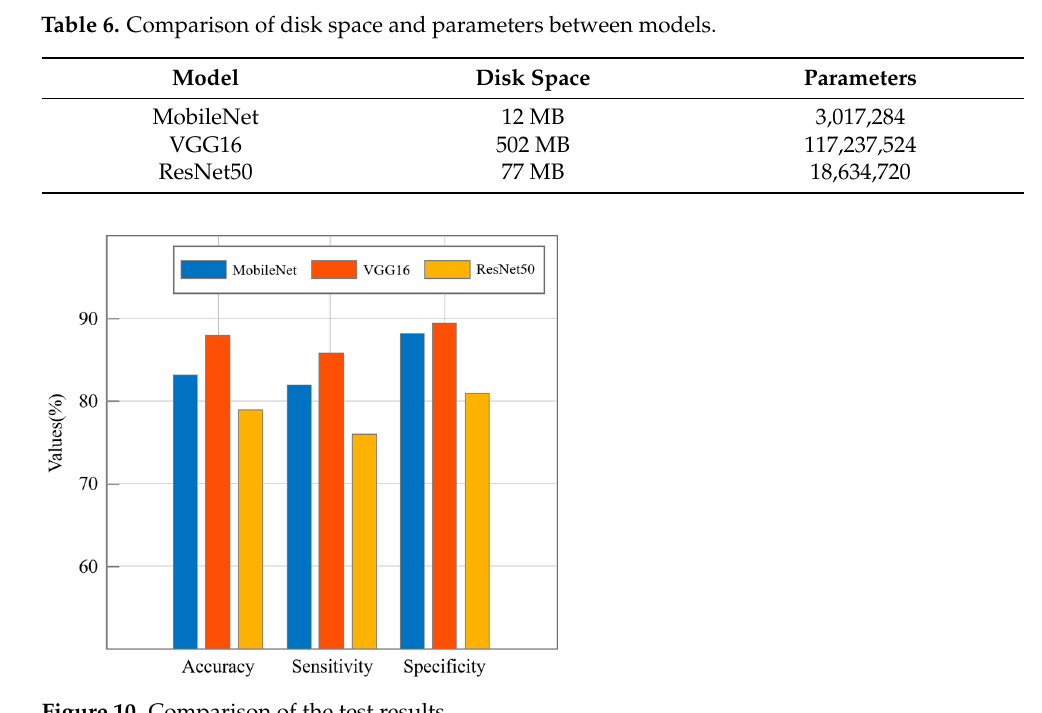
10 of 12 Table 6. Comparison of disk space and parameters between models. Model